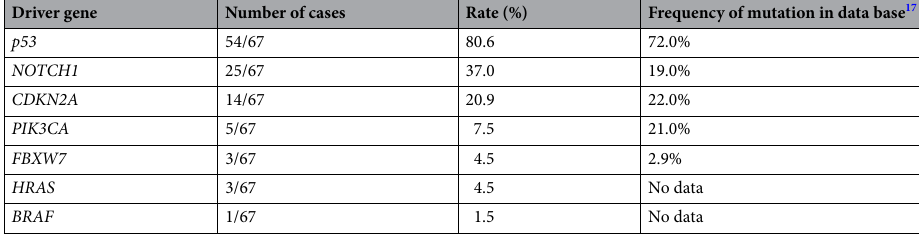
Table 3. Comparison of mutation rates of oncogenic driver genes in OSCC between this study and previous study. *Counting of double mutations: Missense + Truncation (Splice-site variant) → Truncation (Splice-site variant); Truncation (Nonsense) + Truncation (Splice-site variant) → Truncation (Nonsense); Missense + Missense →